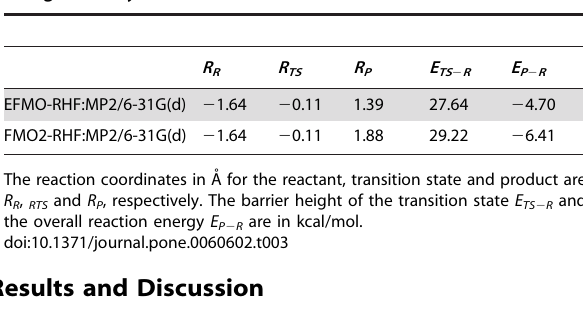
Table 3. Reaction barriers of chorismate mutase calculated using multilayer EFMO and FMO2 calculations.